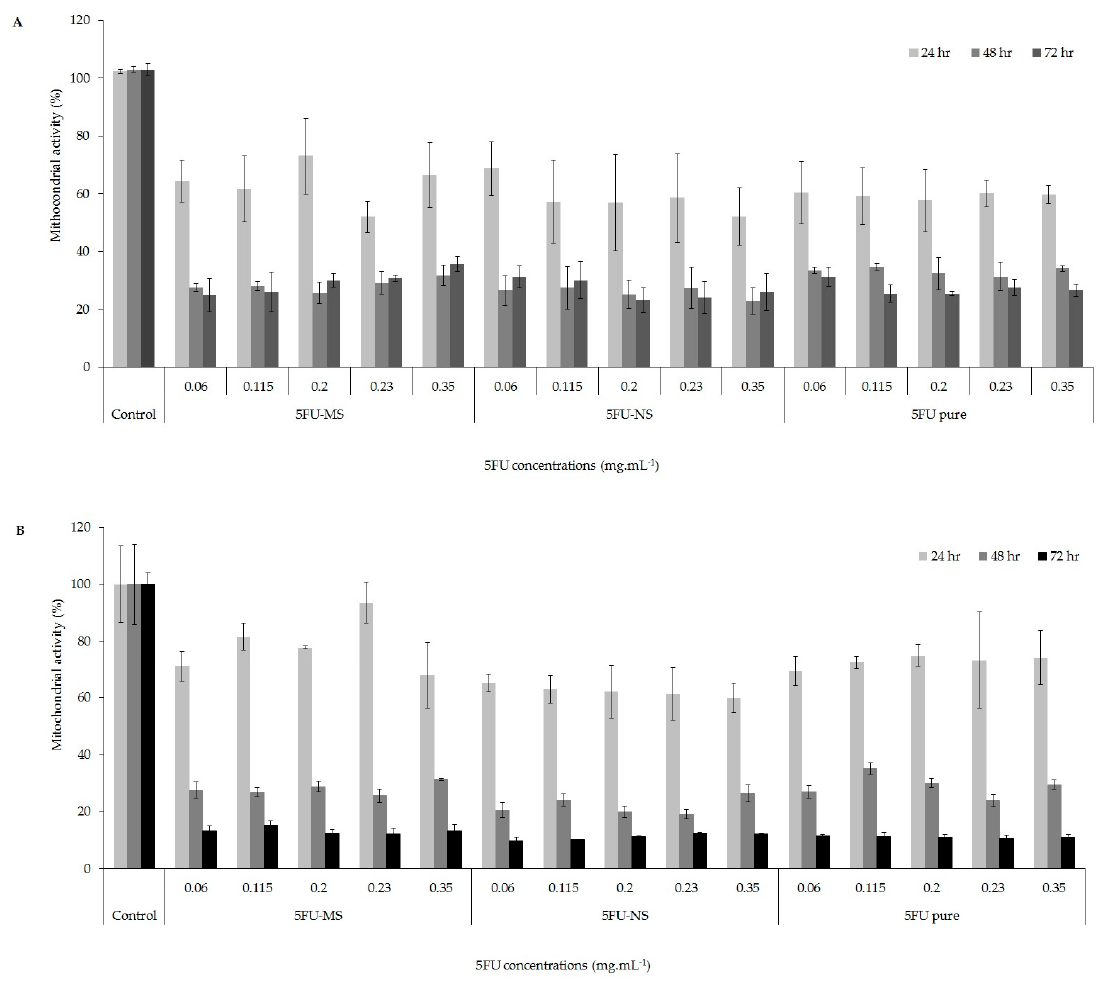
Figure 9. Cell viability (24, 48 and 72 h) of the 5FU-MS and 5FU-NS formulations at five concentrations. 5FU pure was used as a positive control. ( A ) A2058 cell viability; ( B ) A375 cell viability.